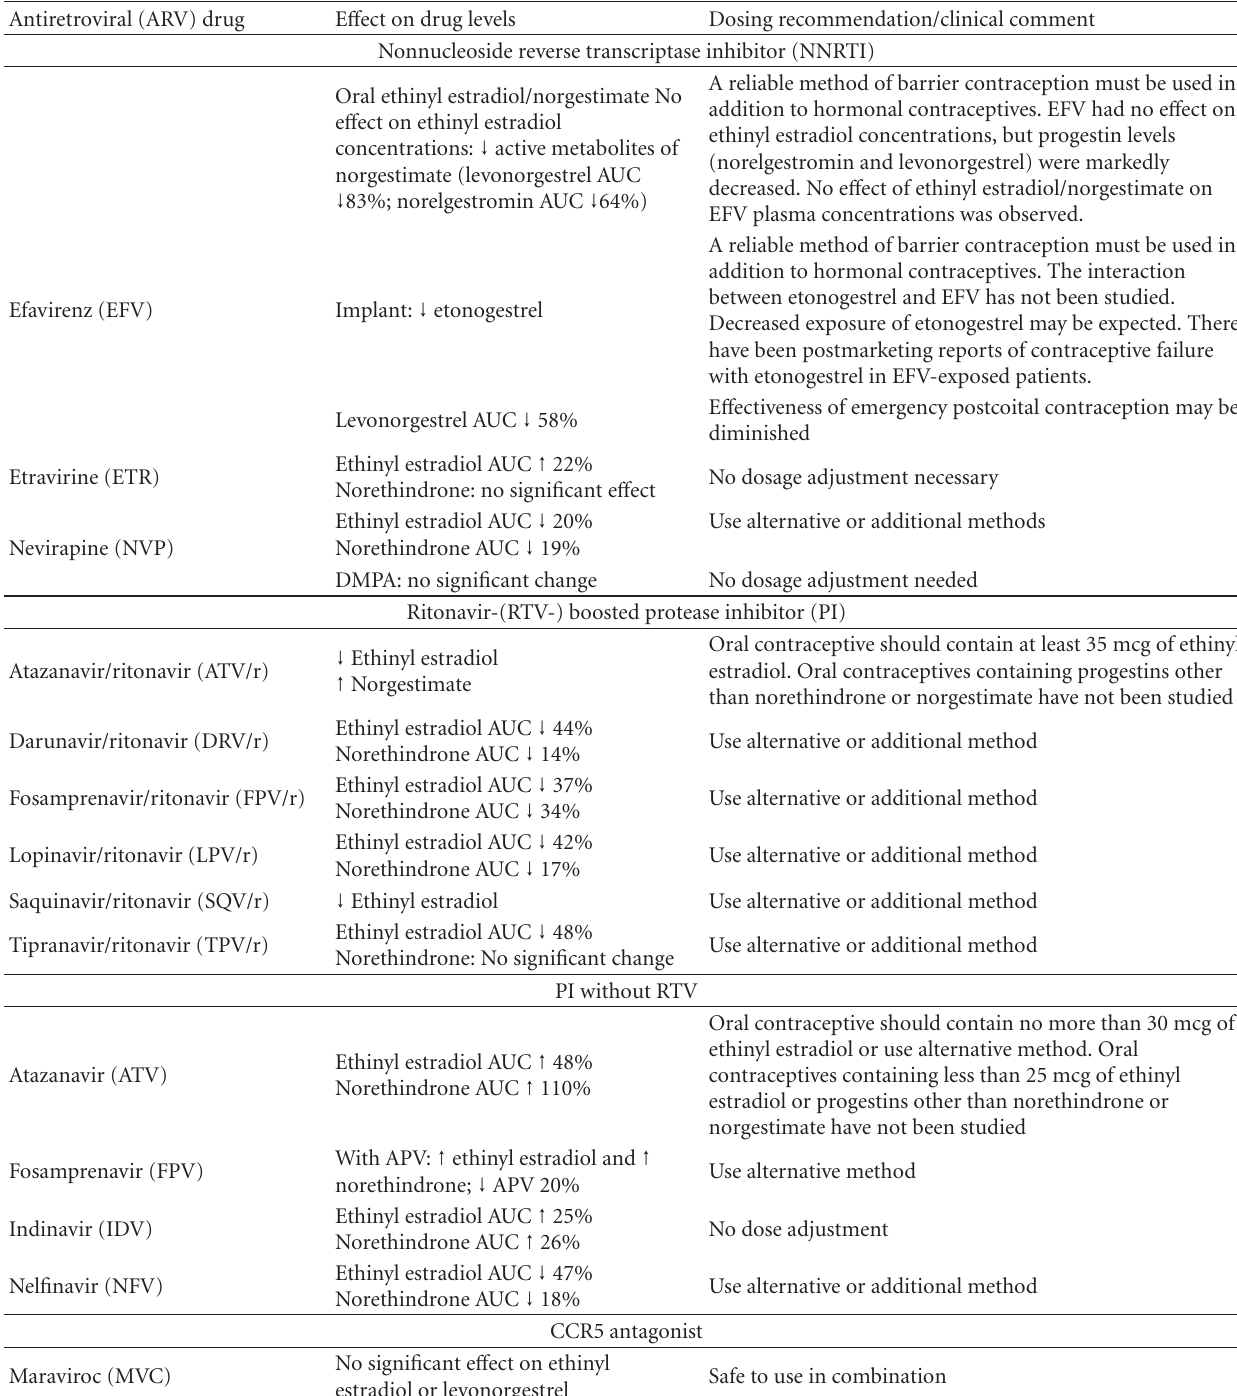
Table 5: Drug interactions between antiretroviral agents and hormonal contraceptives. Antiretroviral (ARV)